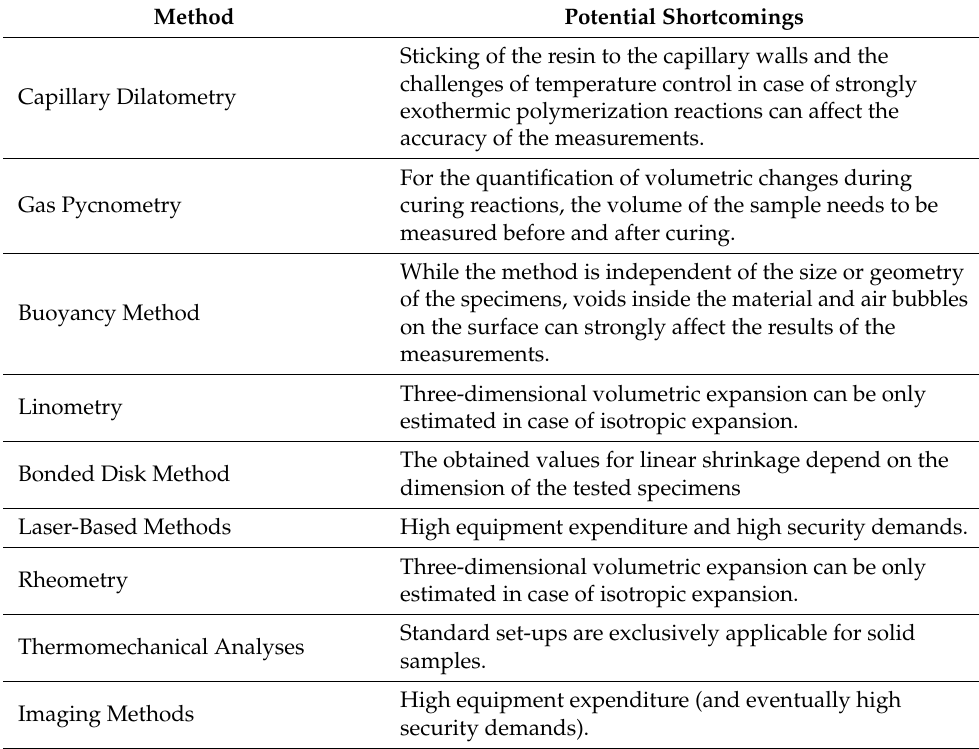
Table 1. Methods for the quantification of volumetric shrinkage and their potential